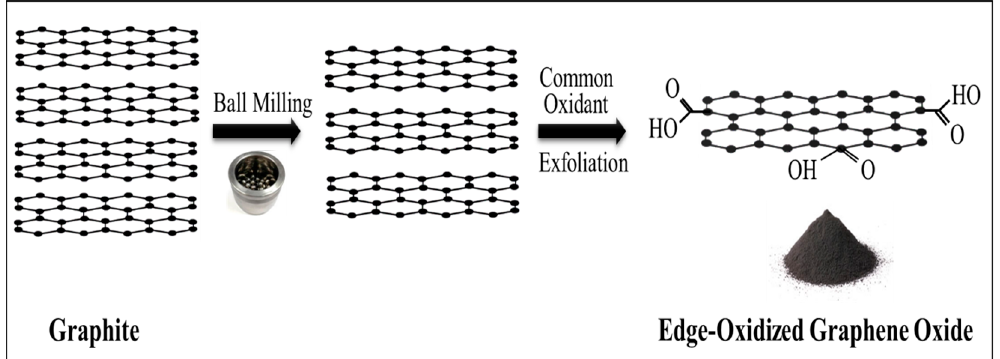
Figure 2. Production methods for producing edge-oxidized graphene oxide (EOGO).